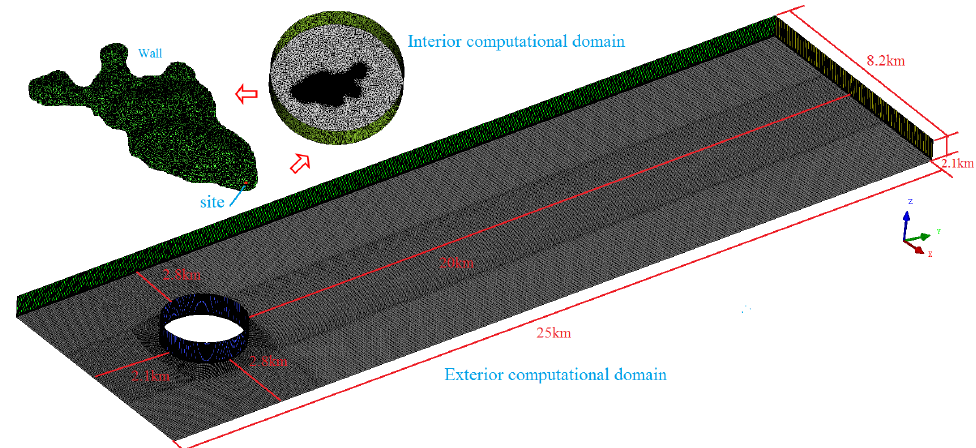
Figure 5. Computational domains and grids.